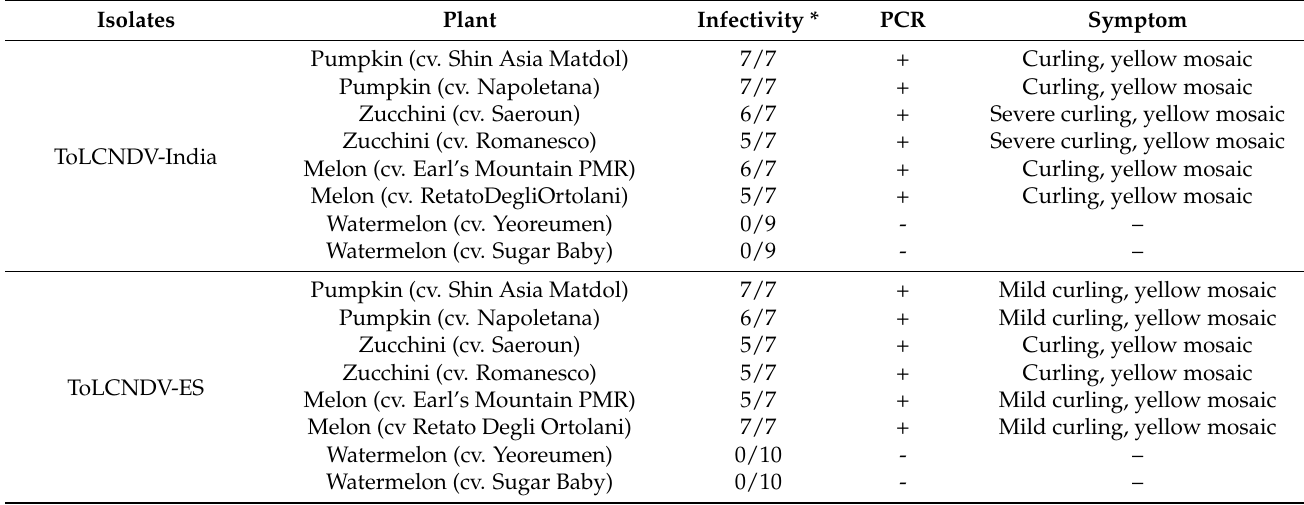
Table 1. Infectivity of two ToLCNDV isolates on Cucurbitaceae plants.